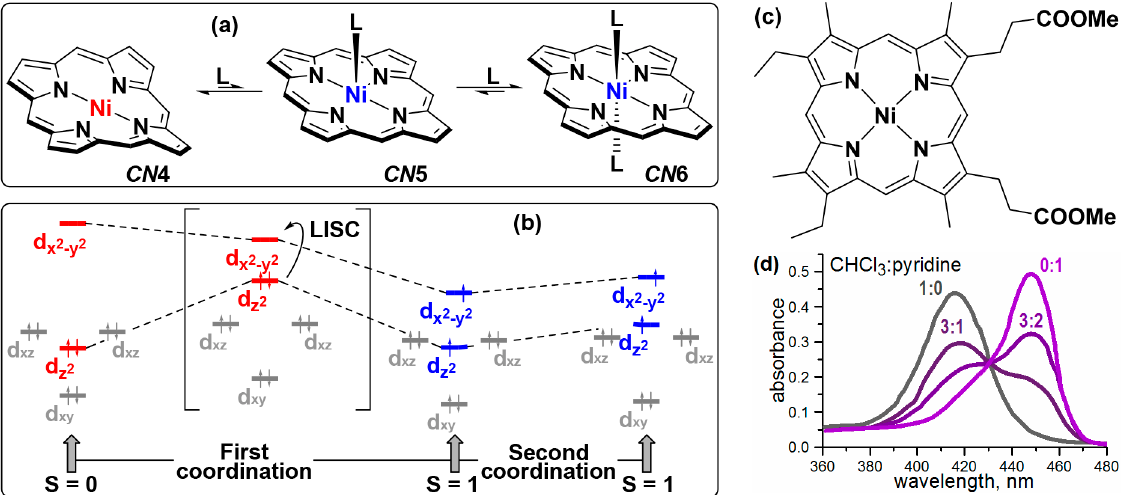
Figure 1. ( a ) axial coordination to Ni(II) porphyrinates, leading to formation of high-spin pyramidal and bipyramidal complexes with coordination numbers CN = 5 and 6; ( b ) partial molecular orbital scheme, depicting the electronic structure of low- and high-spin states of Ni(II) porphyrinates (adapted from Reference [23]); ( c , d ) Ni(II) complex with dimethyl ester of mesoporphyrin IX, for which axial coordination was observed for the first time, and corresponding spectral changes in the Soret band region upon increase of pyridine fraction in the solvent (adapted from Reference [19]).